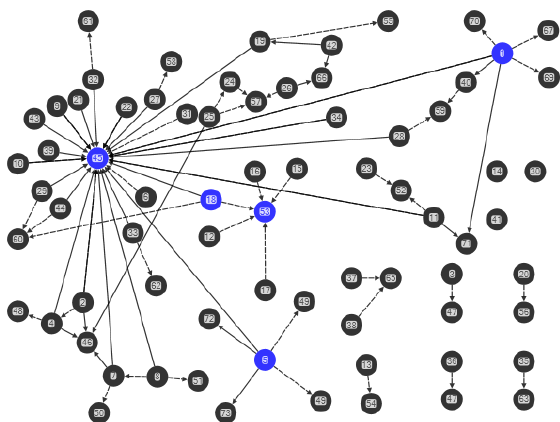
Figure 3. Brokerage in the combined mothers’ health advice-seeking network (Q15, Q23). “Rural 1” left hand side and “Urban 1” right side. Blue nodes indicate individuals with high betweenness centrality, black ties denote health advice nominations and black dashed ties denote general advice nominations.